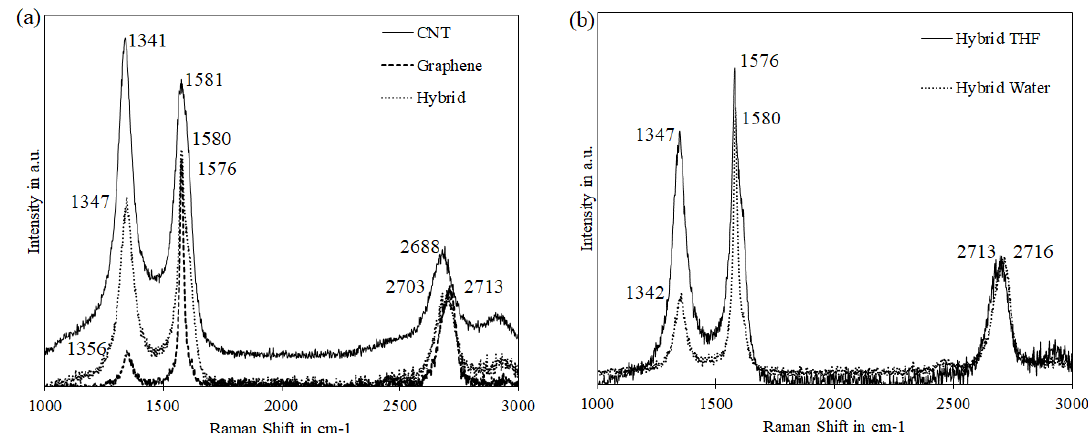
Figure 4. Raman spectra for ( a ) material analysis on the thin films, and ( b ) dispersion comparison of Hybrid thin films based on THF and water.